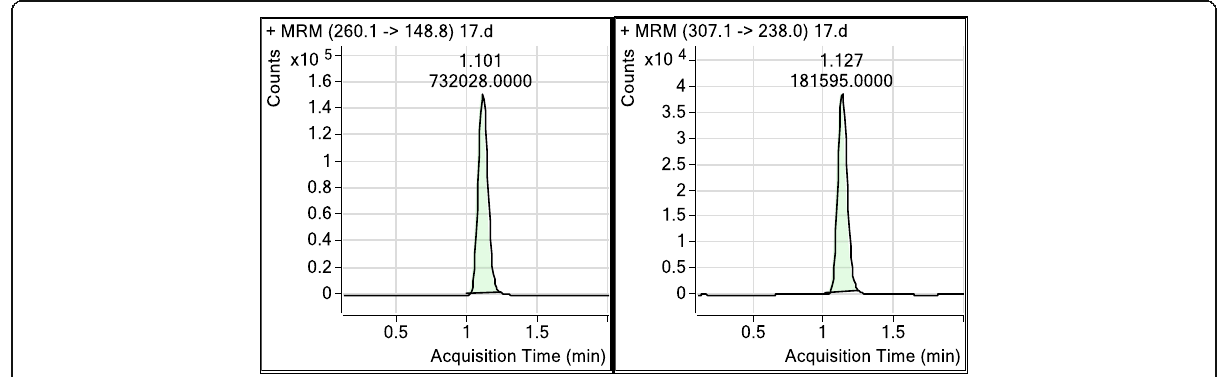
Fig. 3 Representative chromatogram of blank plasma sample spiked with lenalidomide at the HQC of 800 ng/mL and I.S (1000 ng/mL)